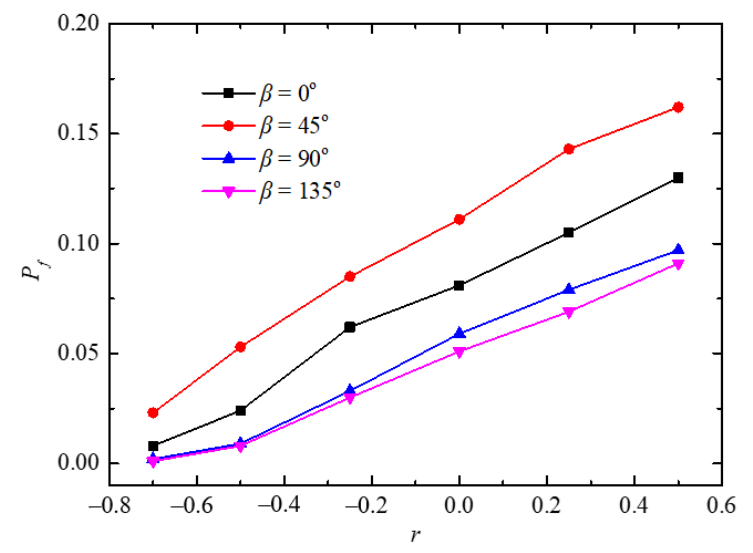
Figure 16. Failure probability with different cross-correlation coefficients and random field rotation angles.